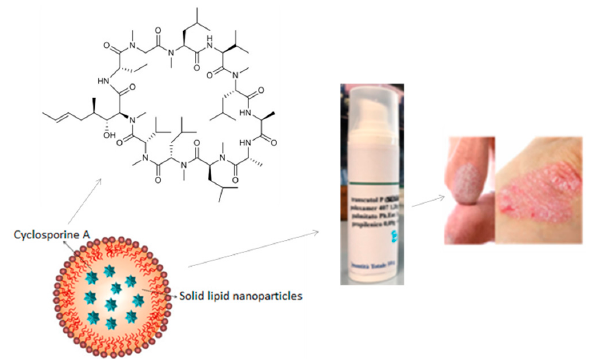
Figure 10. Schematic design of cyclosporin A-loaded SLN formulation.